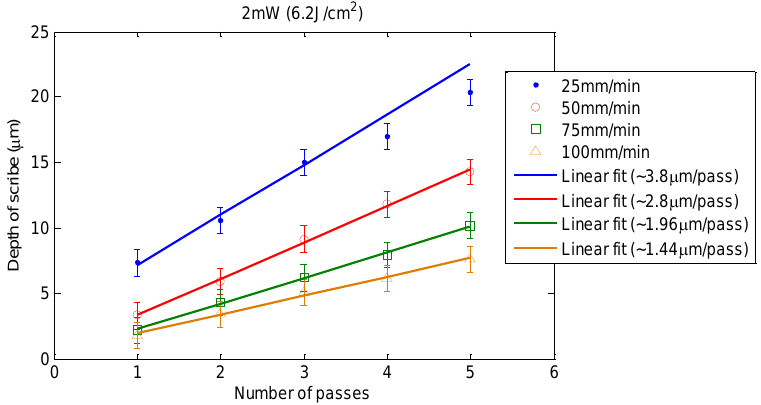
Figure 4. Measured trench depths for one to five passes over a range of translation speeds .